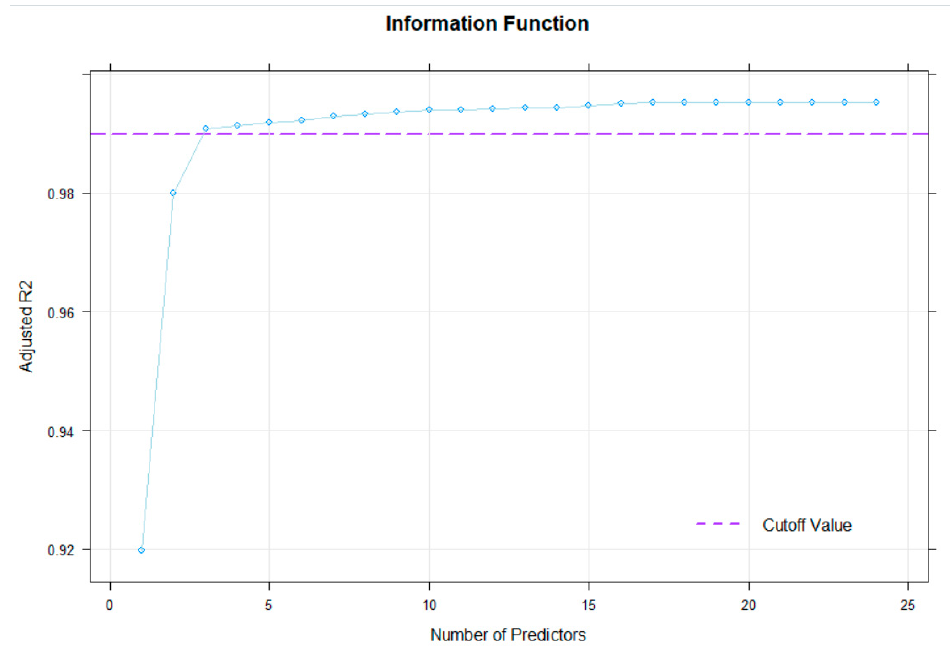
Figure 9. Explained variance depending on number of predictors.